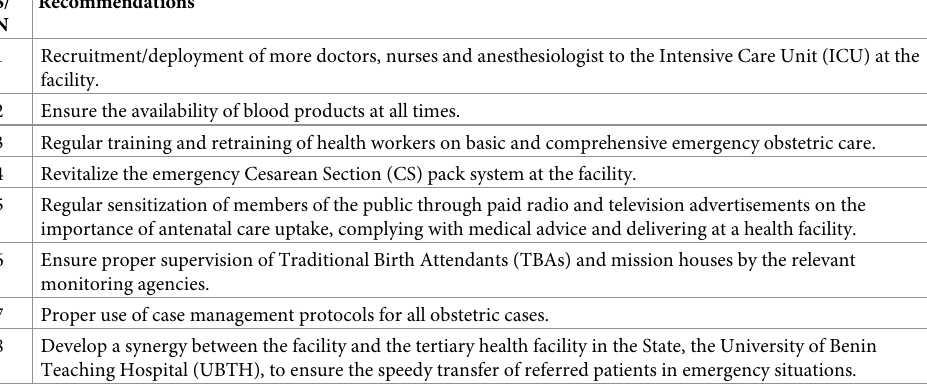
Table 4. Recommendations on Preventing Maternal Deaths at the Central Hospital, Benin City and Policy Response. S/